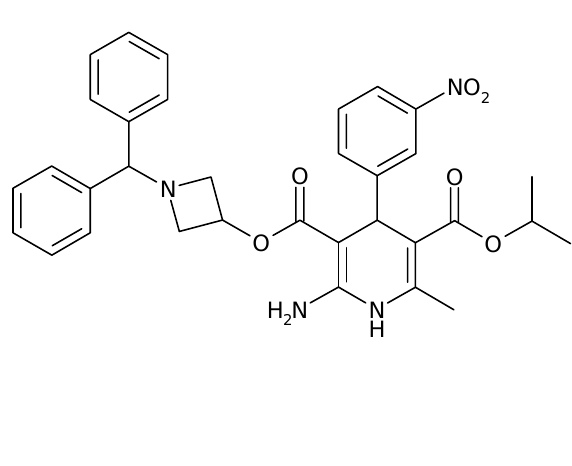
Figure 1. Structure of azelnidipine.